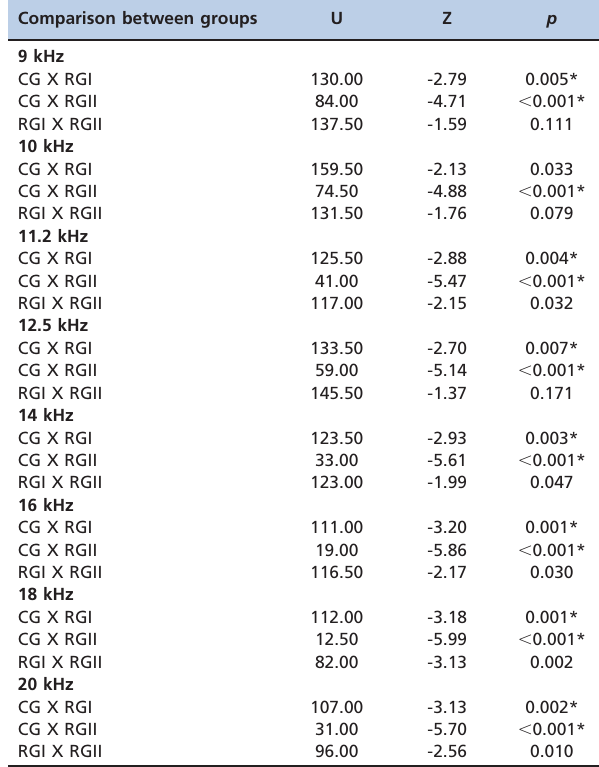
Table 3 - Two-to-two comparisons of the Control Group, Research Group I, and Research Group II regarding the hearing thresholds obtained at high frequencies according to the Mann-Whitney